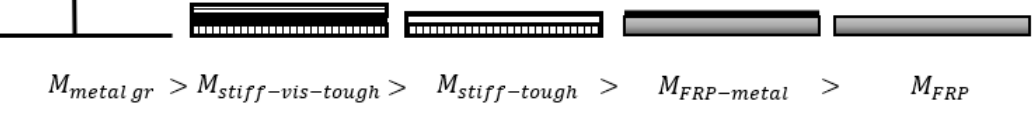
Figure 1. Five structural concepts that will be investigated arranged according to their mass. Table 1. Structural candidates and their parametrization. The term ‘ice stringer / ice stiffener’ refer to members that are directly present underneath the impact location. Structural Concept Structural Element Variants Motivation Plate thickness